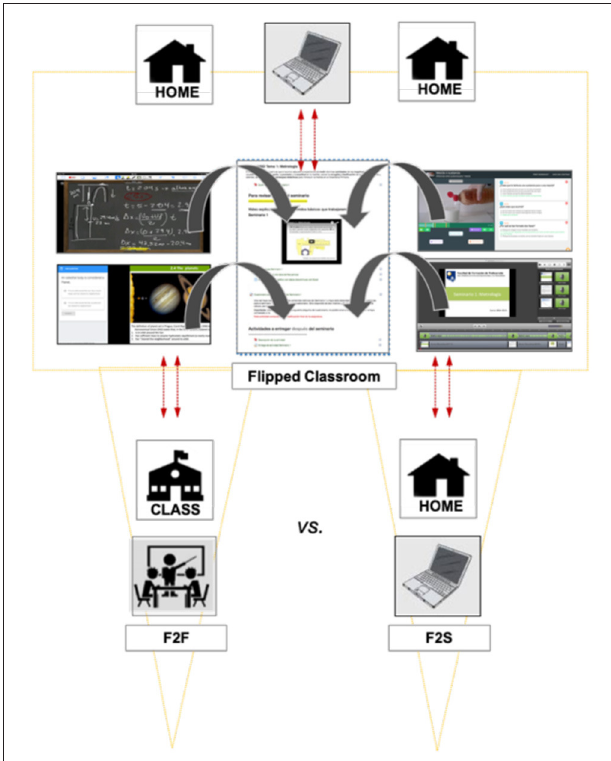
FIGURE 1 | A conceptual framework of a STEM course to examine performance and affective domain between F2F and F2S flipped classroom.